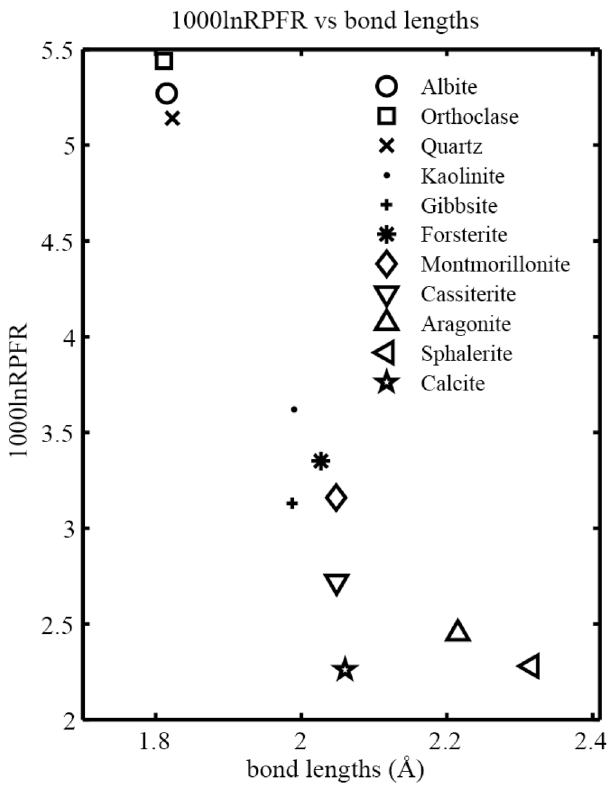
Figure 6. The relationship between 10 3 ln(RPFR)s (100 °C) of different Ga-bearing minerals with bond